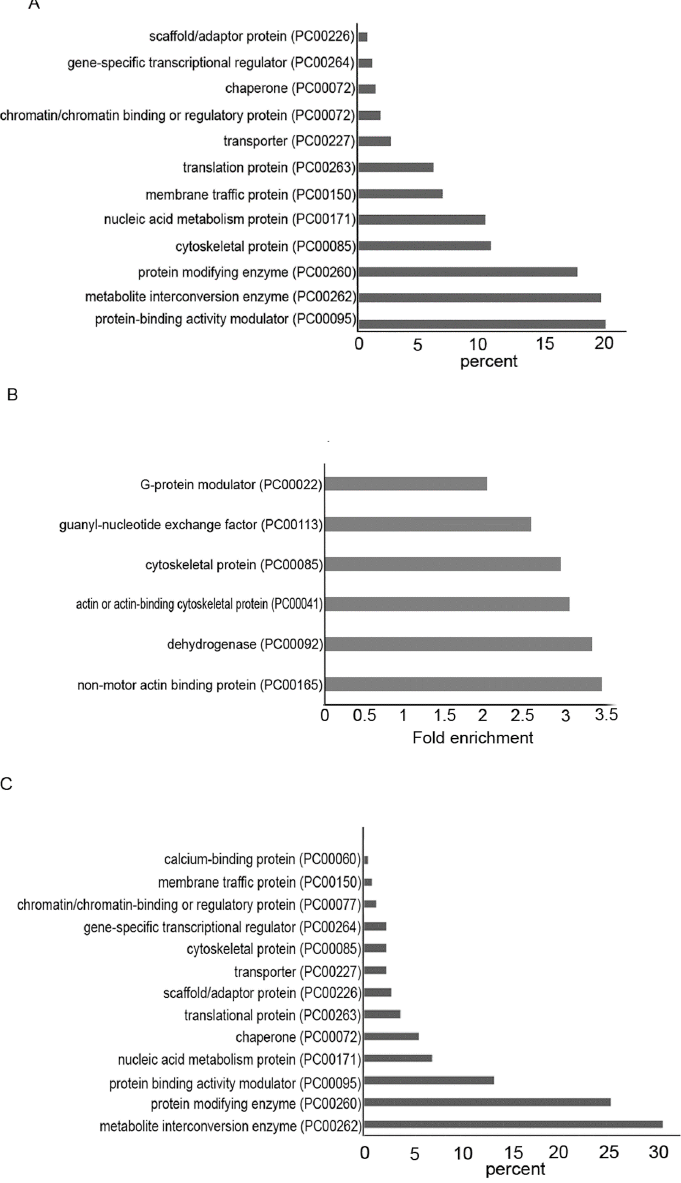
Figure 2. ( A ) PANTHER sequence classification of genes upregulated in AFAT; ( B ) PANTHER statistical overrepresentation test of upregulated genes in AFAT; ( C ) PANTHER sequence classification of genes downregulated in AFAT.